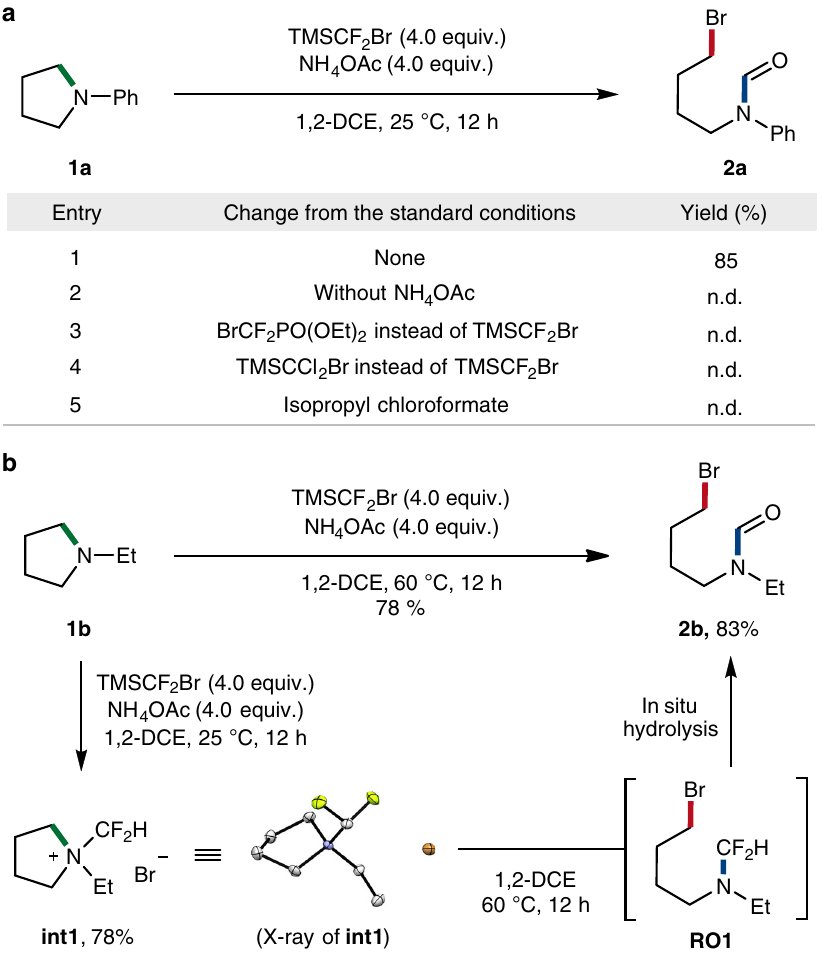
Fig. 2 Reaction development. a Selected optimization conditions for the ring-opening bromoformylation of N -phenylpyrrolidine 1a ; All reactions were performed on a 0.2 mmol scale; 1,2-DCE, 1,2-dichloroethane; n.d., not detected; Isolated yields. b Isolation of an ammonium salt intermediate from N - ethylpyrrolidine 1b